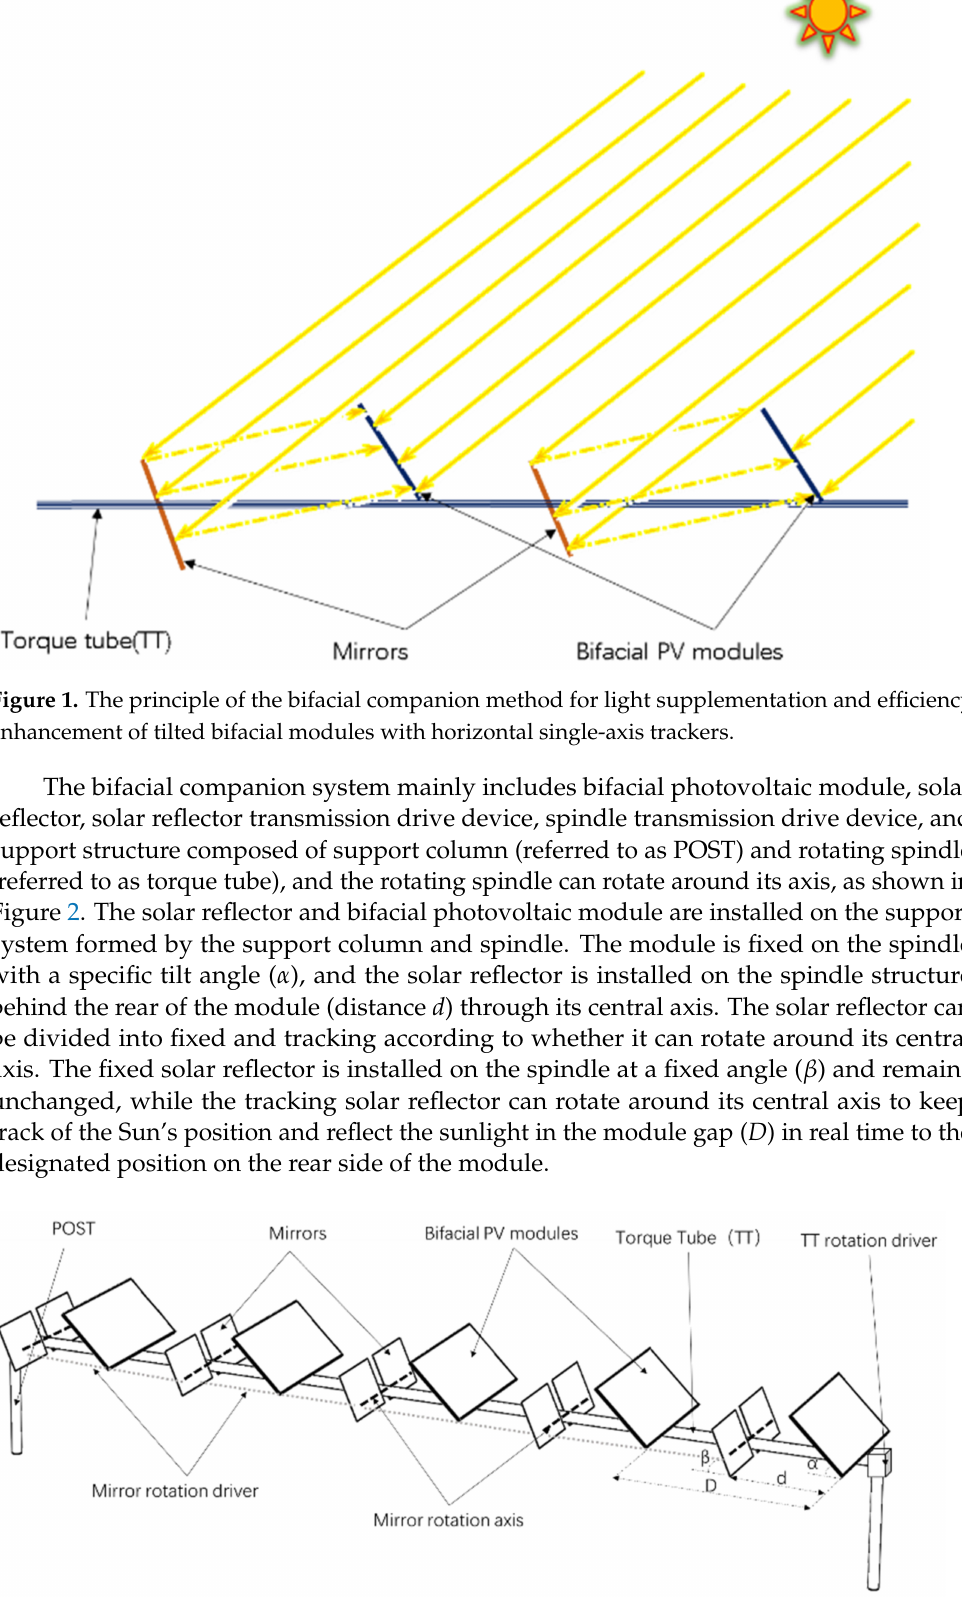
Figure 2. Schematic diagram of the structural composition for light supplementation and efficiency enhancement of tilted bifacial modules with horizontal single-axis